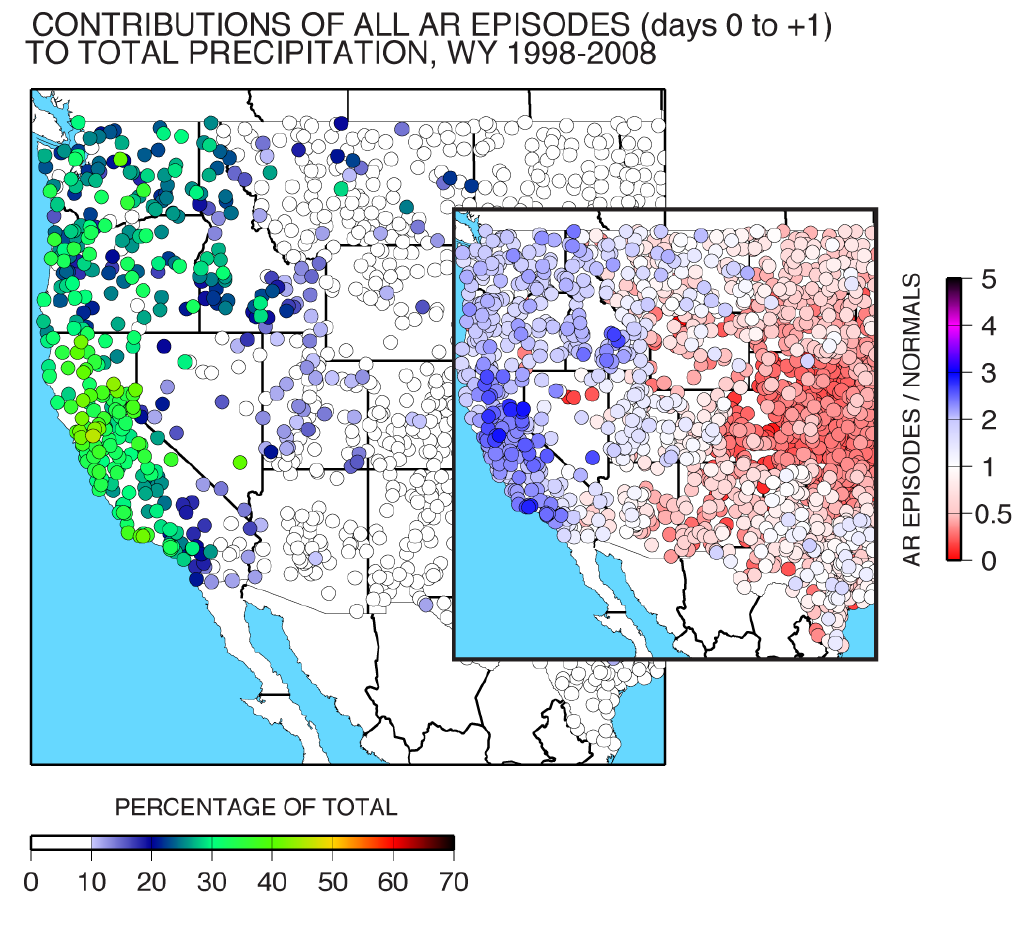
Figure 6. Contributions of precipitation during wet-season (November–April) days on which atmospheric rivers made landfall on the West Coast (based on Table 1) to overall precipitation from water year 1998 through 2008 at cooperative weather stations in the western US. Inset map shows the ratio of average precipitation on the AR days (including concurrent day and following day) to climatological means for the same combination of days. Concurrent and one following day are composited here to allow for a 1-day uncertainty between the GMT-based AR chronology and local-time cooperative precipitation